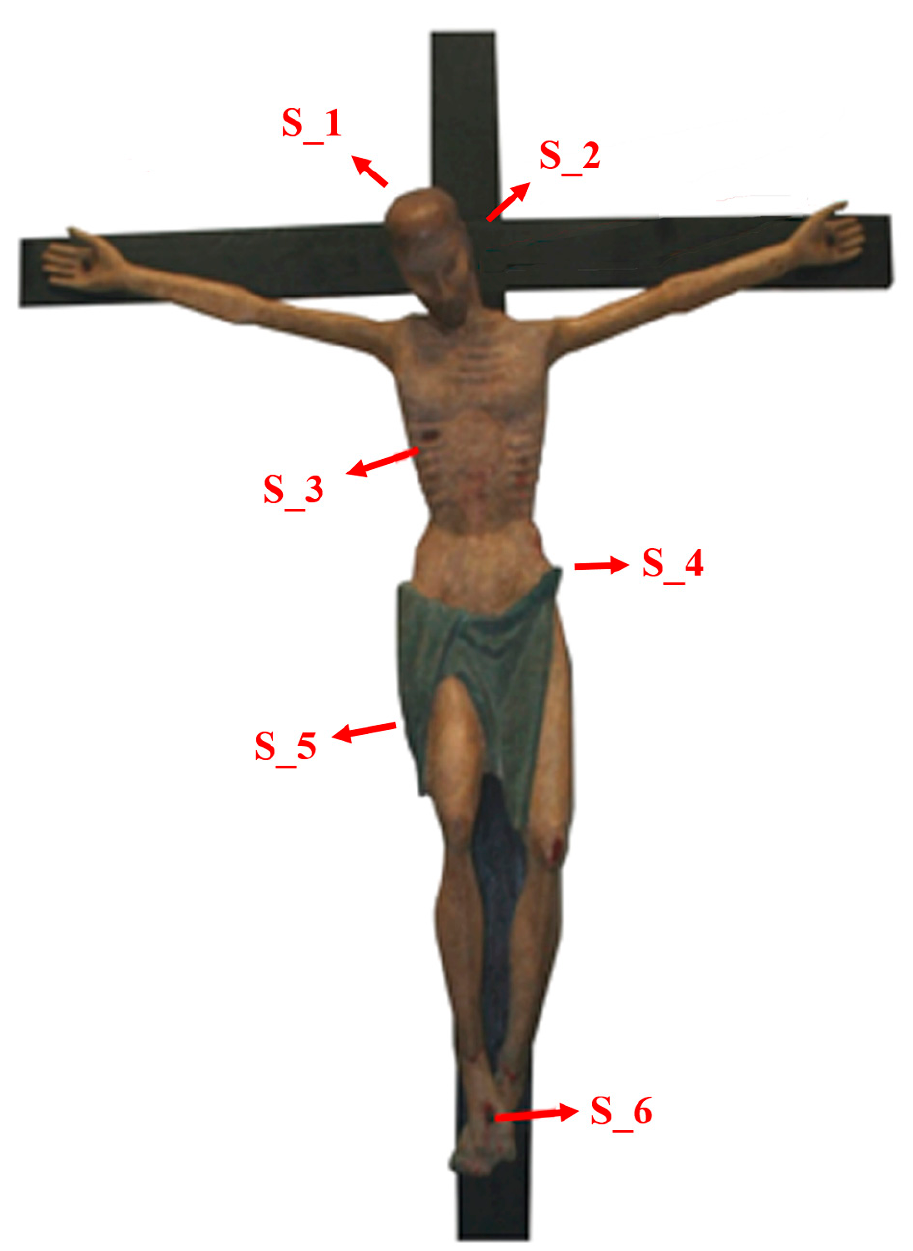
Figure 1. The Crucifix under investigation (after the 2012 restoration). The arrows indicate the parts where the six specimens were obtained.